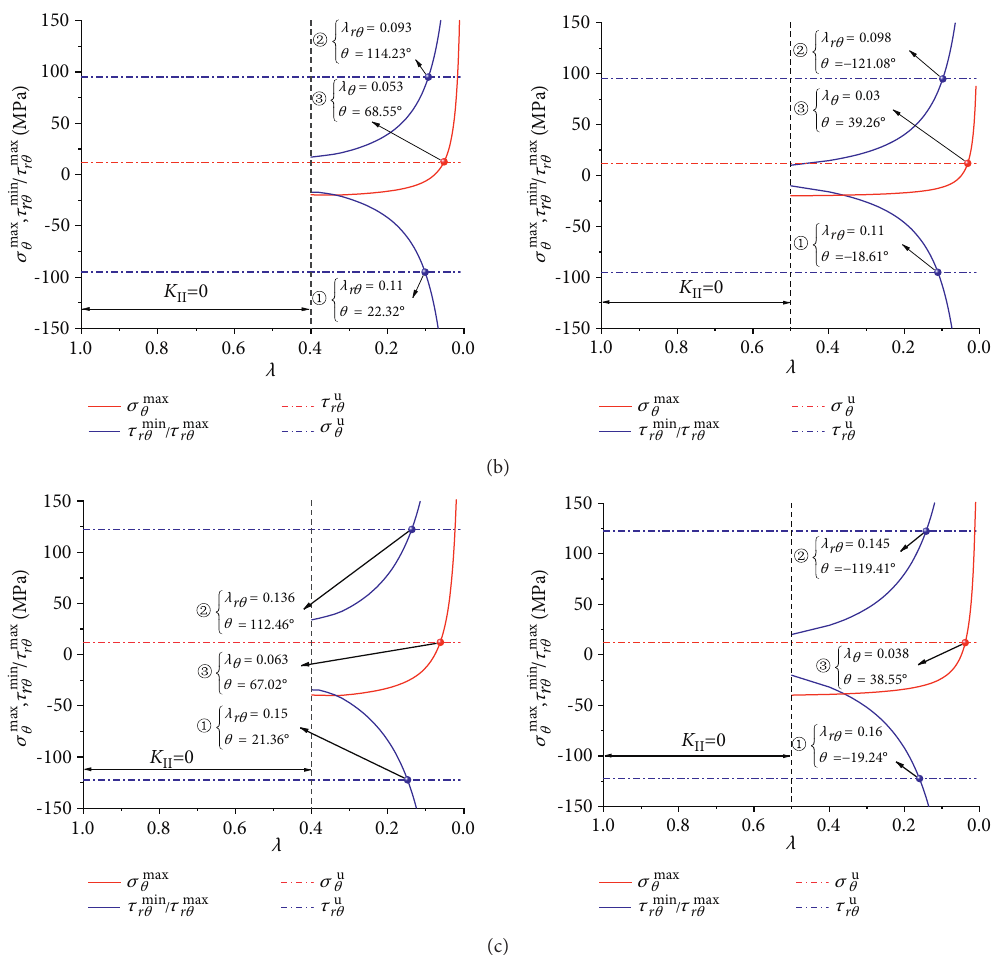
Figure 14: The changes of σ max θ , τ min rθ , and τ max rθ of two different samples under different confining pressures. (1) β σ 3 � 5 MPa (1) β � 30 ° , (2) β � 60 ° (b) σ 3 � 20MPa (1) β � 30 ° , (2) β � 60 ° (c) σ 3 � 40MPa.